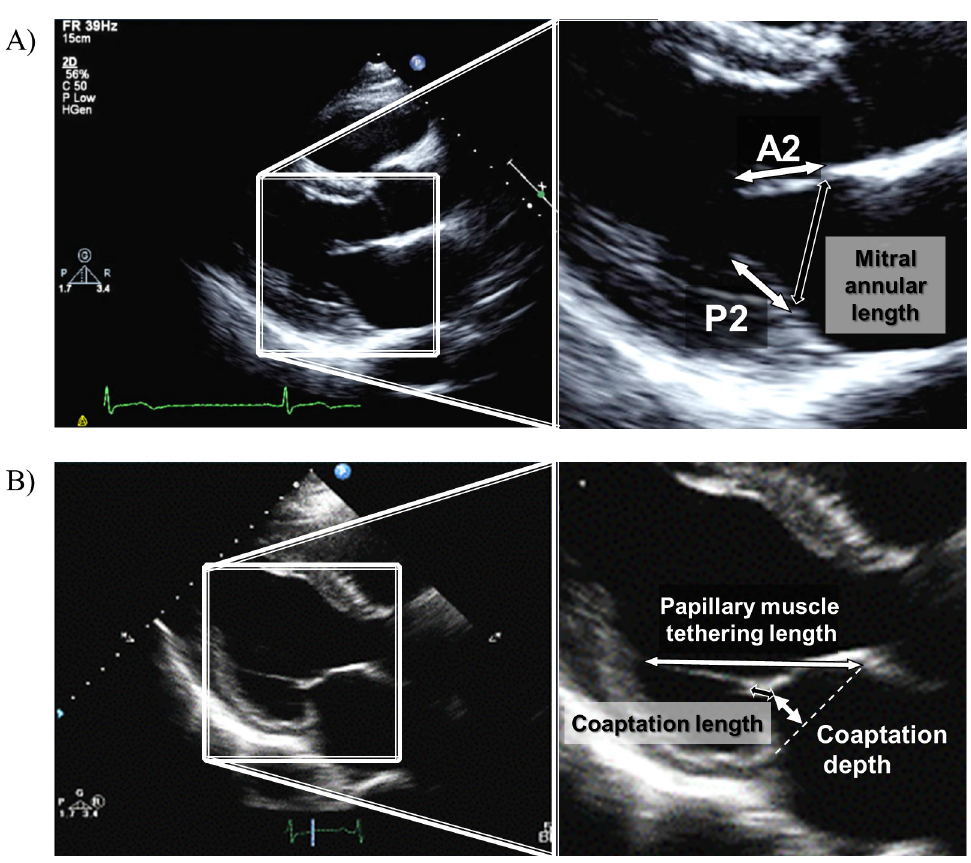
Fig 2. Measurement of mitral leaflet lengths, mitral annular lengths, coaptation lengths and depths, and papillary muscle tethering lengths. (A) The P2 (white bidirectional arrow) and A2 (white bidirectional arrow) lengths, and mitral annular lengths (black bidirectional arrow) were measured at end-diastole using a left ventricular long axis view. (B) The coaptation lengths (white bidirectional arrow) and depths (black bidirectional arrow), and papillary muscle tethering lengths (white bidirectional arrow) were measured at end-systole using a left ventricular long axis view.